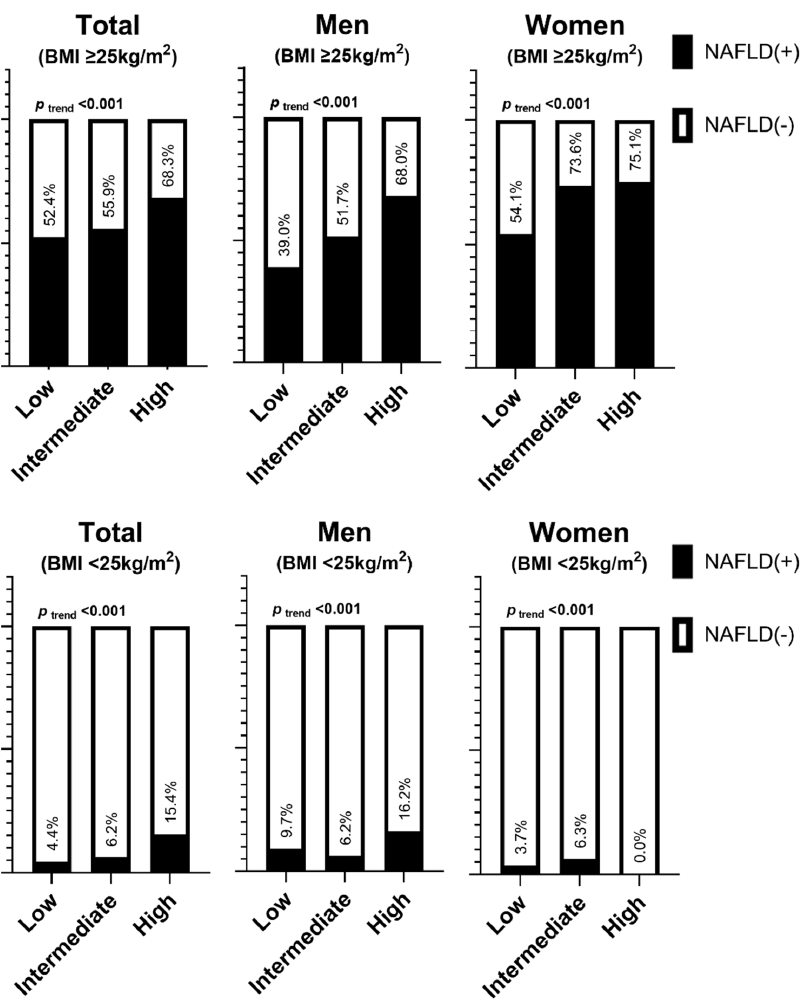
Figure 2. Prevalence of nonalcoholic fatty liver disease according to the risk of having obstructive sleep apnea by sex and obesity status. Table 2. Relationship between the risk of having OSA and NAFLD by